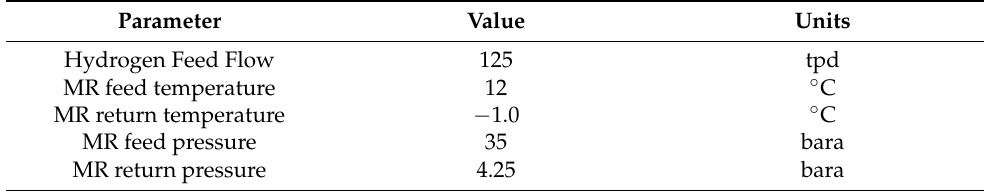
Table 4. Validation case MR modelling